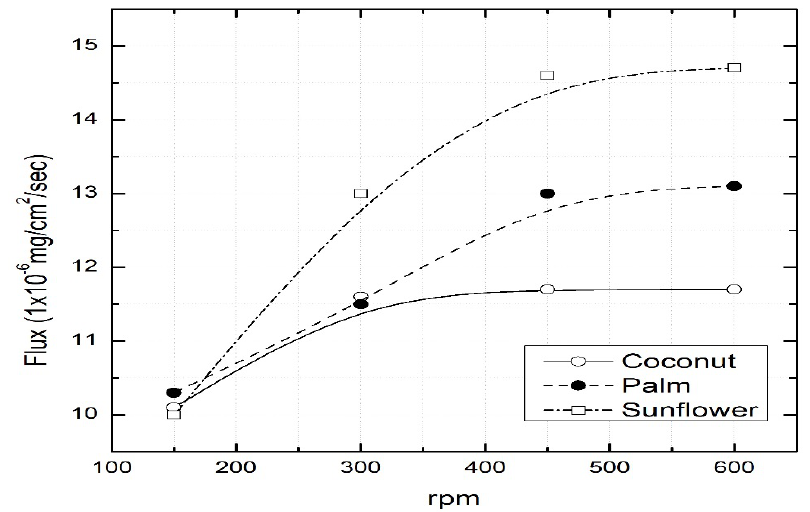
Figure 5. Impact of stirring speed (rpm). Feed = 300 mg / L dye concentration at pH 11; stripping chamber = 0.25 M HCl; permeation time = 8 h.